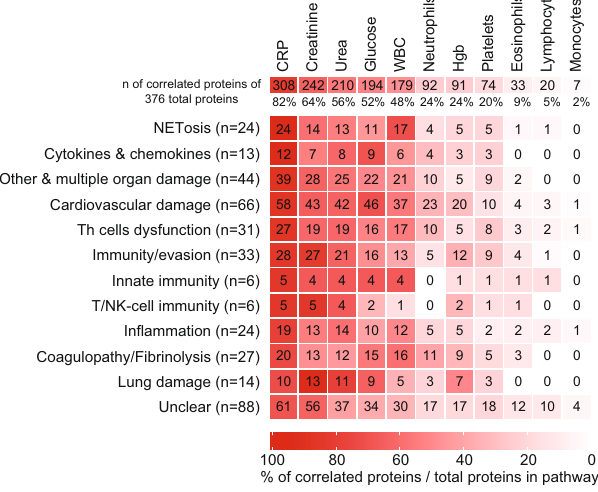
Fig. 3 Correlation between the clinical blood markers and the differentially expressed plasma proteins. The correlation between the expression of the 375 differentially expressed plasma proteins and the available blood markers and blood cell counts in our cohort was evaluated. The overall number (and the percentage) of the DEPs which correlated (signi fi cance of p < 0.05, two-tailed, using Pearson ’ s correlation, GraphPad Prism) with each clinical measurement are shown in the top row. The heatmap shows the number of DEPs (and the percentage depicted by the heatmap colors), which correlated with each clinical parameter strati fi ed by the functional annotations shown in Fig. 2. CRP showed the highest number of overall and function-speci fi c correlations with the